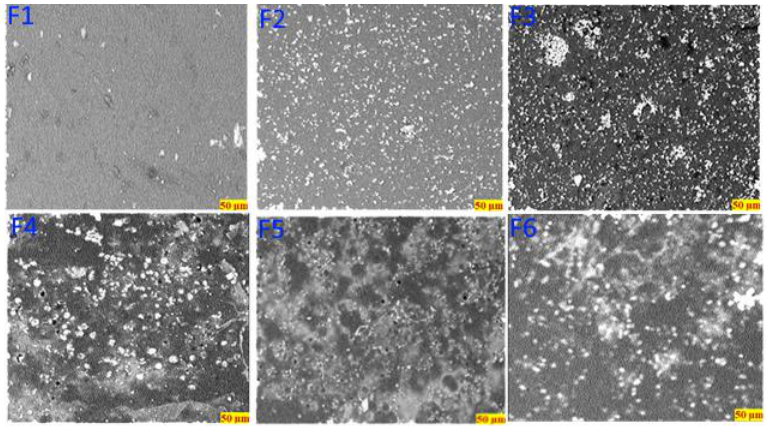
Figure 2. Micrographs of the biocomposite films with 50 µm magnification. For sample codes F1 to F6, refer to Table 1.